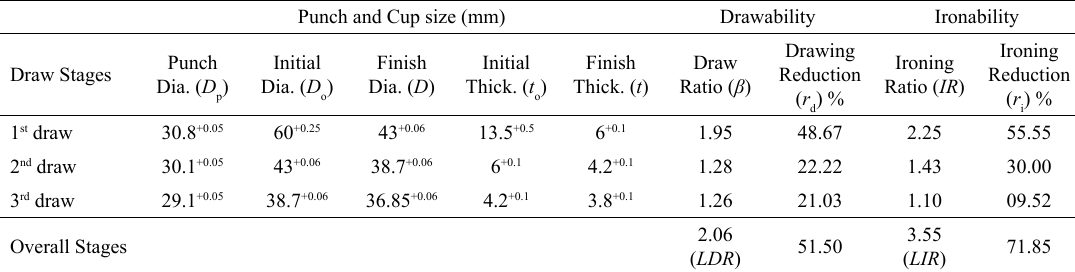
Table 4. Drawability and Ironability obtained in 3-stage cup drawing